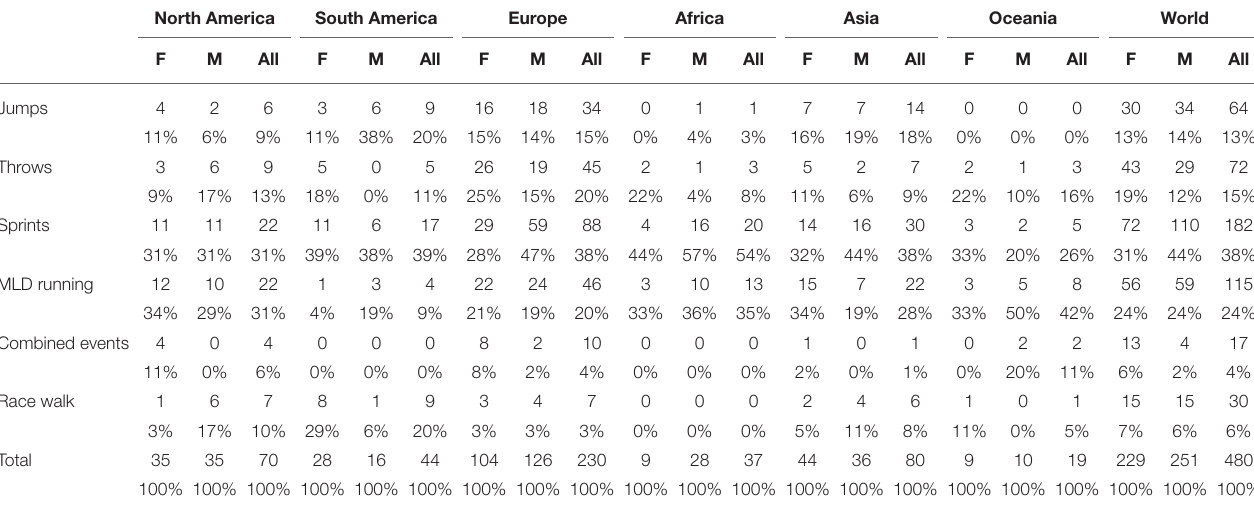
TABLE 3 | Distribution of athletes by geographical area, gender, and event/discipline. North America South America Europe Africa Asia Oceania World